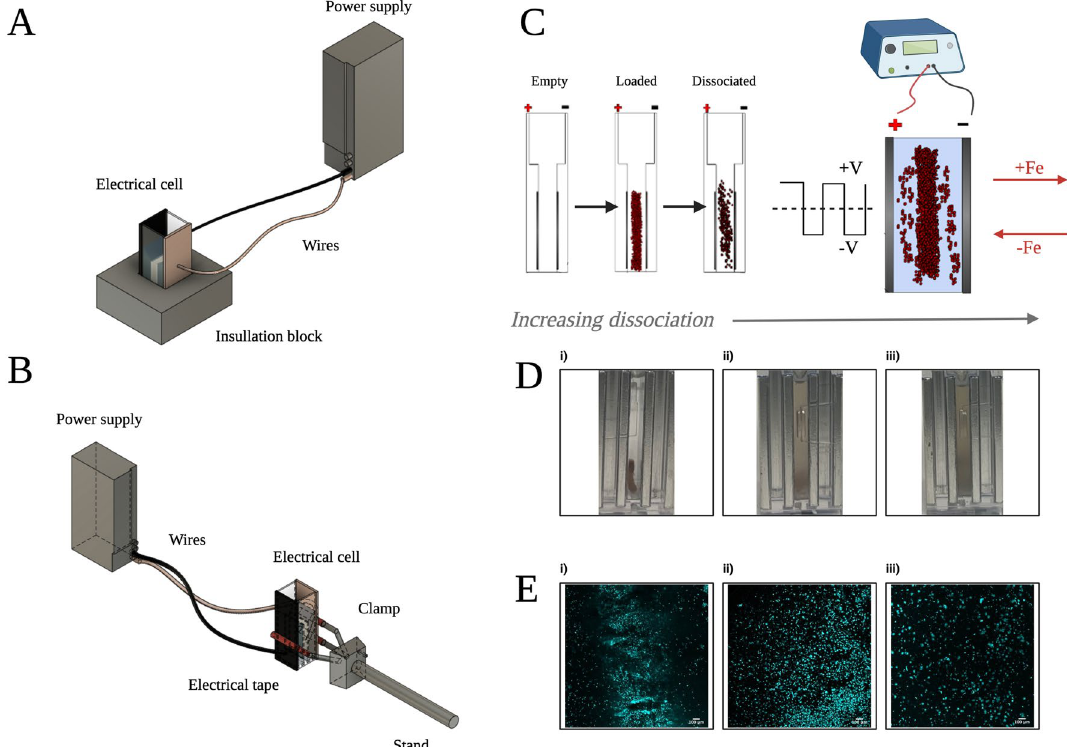
Figure 2. Schematic of the electrical tissue dissociation device configurations and dissociation process. ( A , B ) illustrate the different electrical device configurations used in the short time course (< 5 min) and long-time course (< 30 min) trials, respectively. ( C ) Schematic representation of the process of electrical dissociation. Pictures of dissociating tissue within 2 mm gap are represented in ( D ), while corresponding microscopy images taken in real time are represented in ( E ). ( Di , Ei ) represent a baseline of dissociation corresponding to having just submerged the tissue. A small number of surface cells are immediately washed off. ( Dii , Eii ) represent ~ 50% dissociation of the tissue, while figures ( Diii , Eiii ) represent ~ 100% dissociation of the tissue using applied electric fields. All qualitative results presented were quantitatively validated using flow